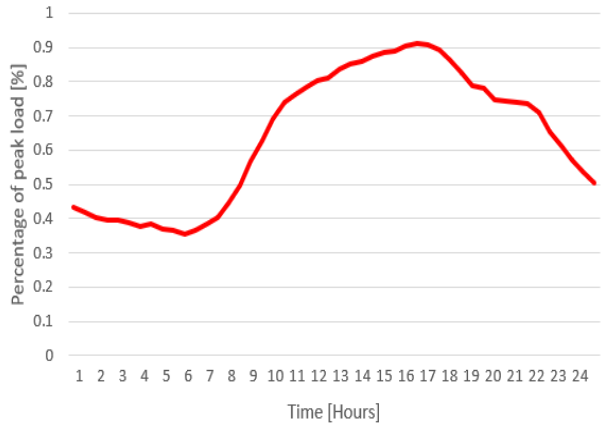
Figure 4. Typical base load curve.